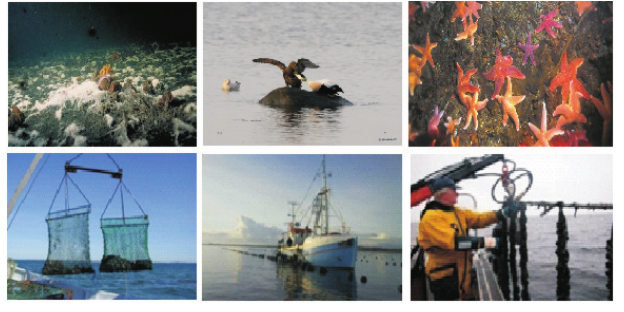
Fig. 2. The Limfjord study site environment and selected stakeholders. From left, top row: a mussel bed after a hypoxia event, blue mussel ( Mytilus edulis ) predators, Common Eider ( Somateria mollissima ), and Common Starfish ( Asterias rubens ); bottom row: mussel dredging, line-mussel farm, and line-mussel husbandry (top row photographs by Peter Bondo Christensen, Carsten Siems, and Karsten